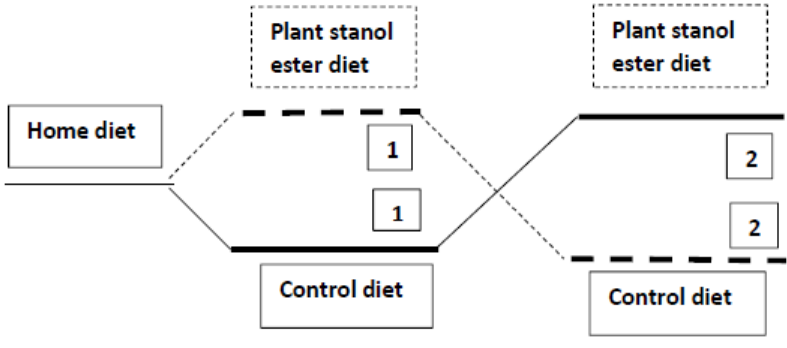
Figure 1. The study procedure. Each period lasted for 7 weeks.